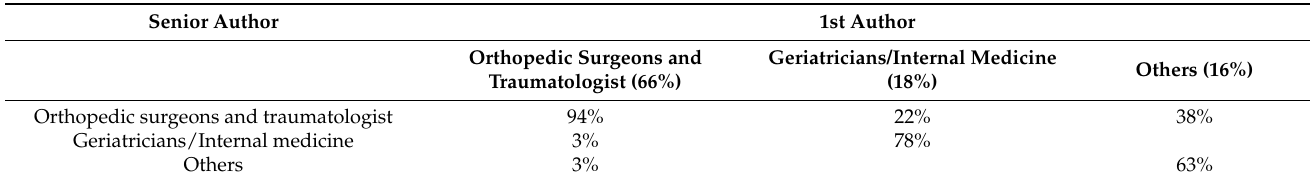
Table 3. Distribution of first and senior authors’ specialties (in